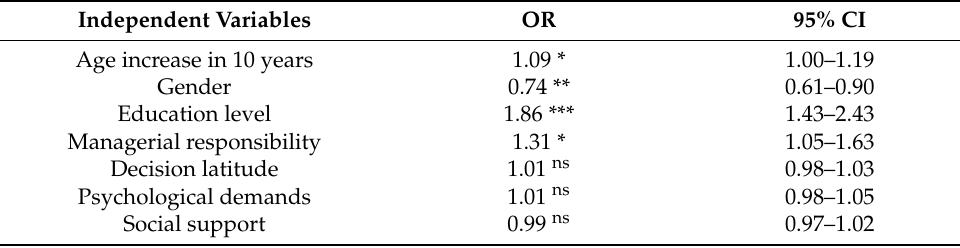
Table 2. Unadjusted associations with alcohol-related presenteeism ( n =